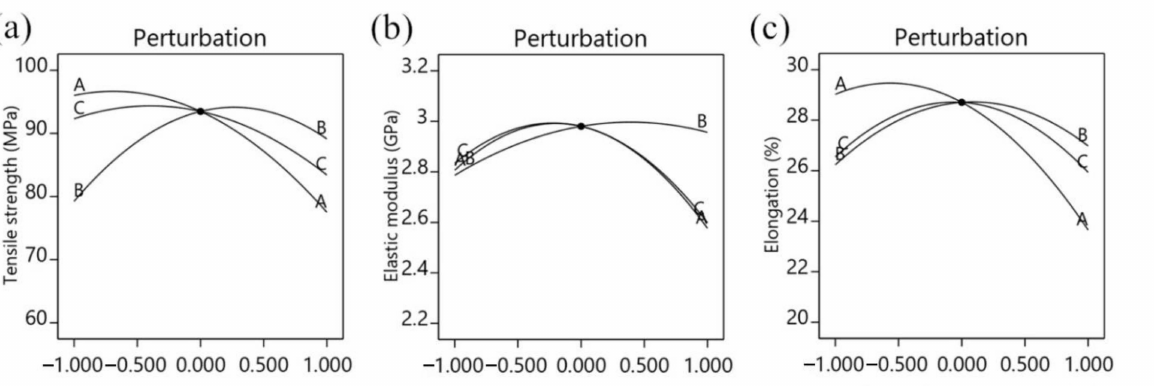
Figure 3. Perturbation plots: ( a ) Effect of factors on tensile strength, ( b ) effect of factors on elastic modulus, ( c ) effect of factors on